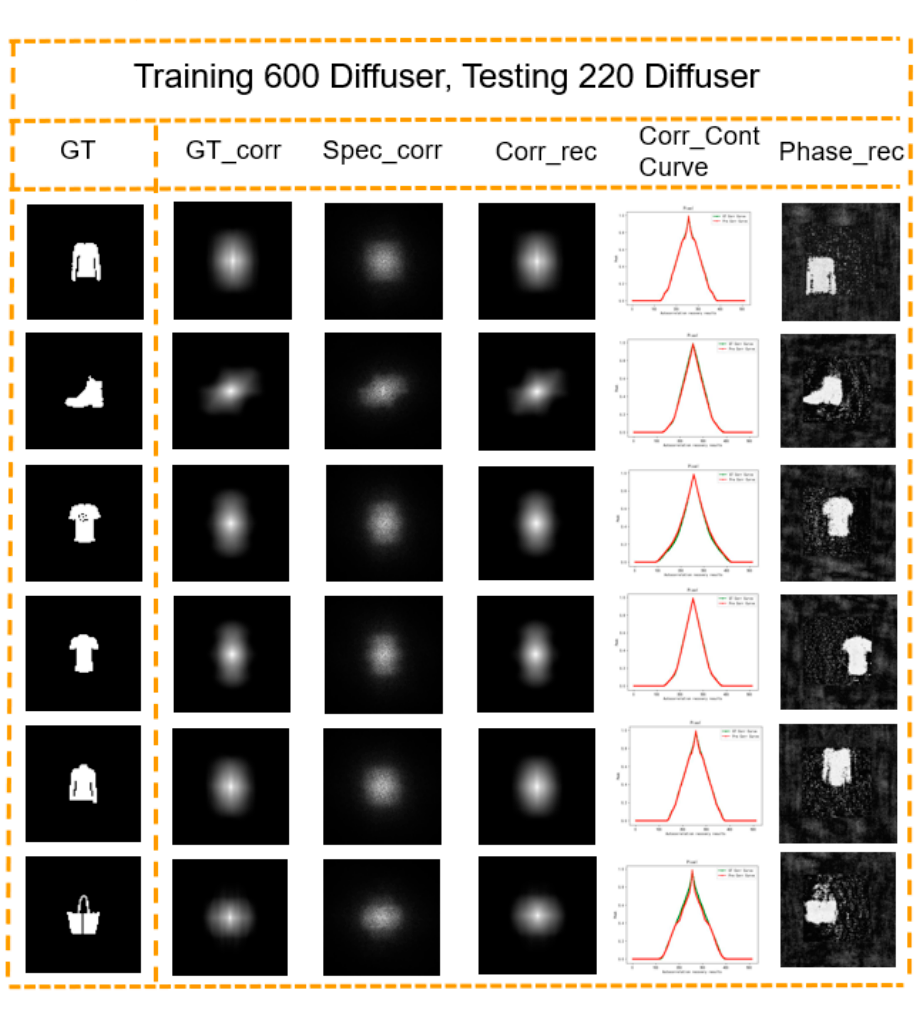
Figure 11. Results obtained using 600-mesh frosted-glass collection data as the training set and testing on 220-mesh frosted-glass collection data.